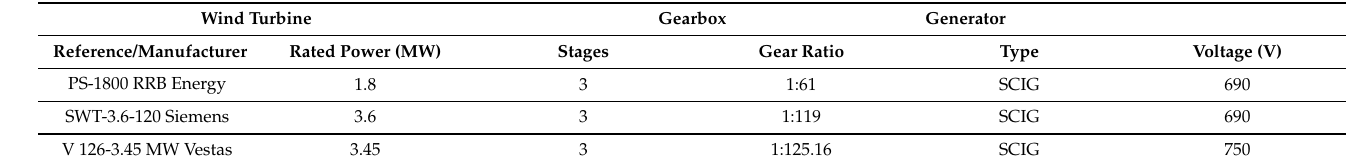
Table 3. Example of multi-megawatt variable speed with full scale frequency converter wind turbine concept (SCIG system with three-stage gearbox).